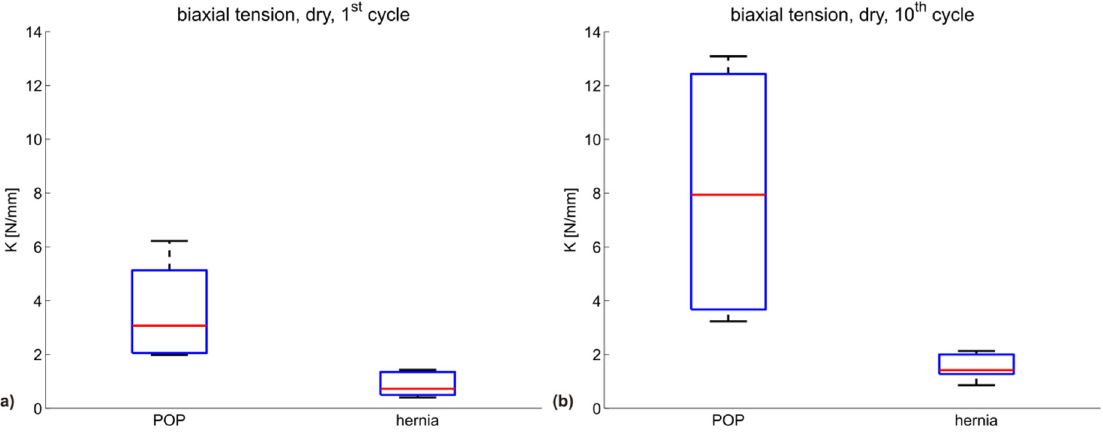
Figure 4. Box plots for uniaxial secant stiffness K uni (N/mm) for all meshes in four configurations: ( a ) dry mesh, first cycle; ( b ) dry mesh, 10th cycle; ( c ) embedded mesh, first cycle; ( d ) embedded mesh, 10th cycle. The red line marks the median of the group; the box represents the 25th and 75th percentile; the extended whiskers the most extreme data points. The + sign indicates an